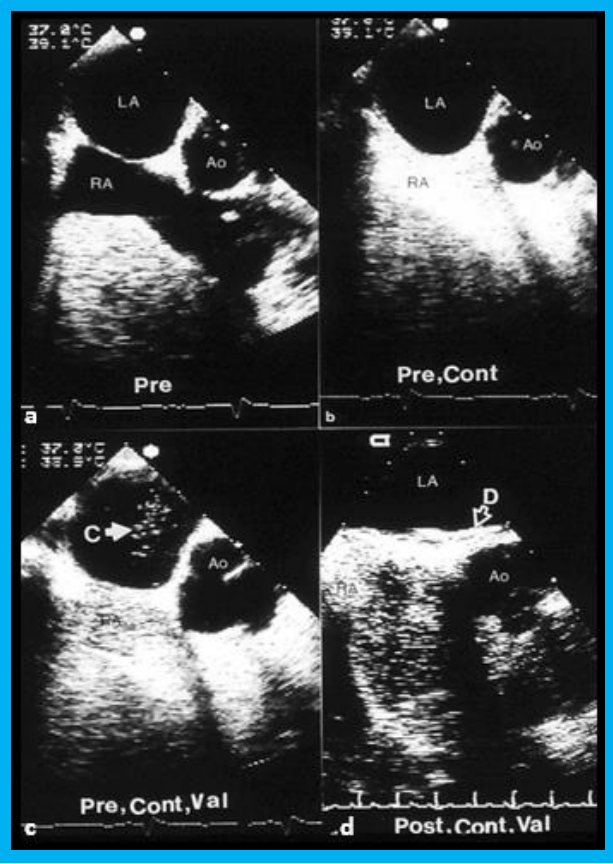
Figure 11. Selected video frames from transesophageal echocardiograms in an adult with presumed paradoxical embolism prior to (Pre) ( a – c ) and six months (post) ( d ) after closure of patent foramen ovale with buttoned device: Short axis views illustrate aorta (Ao) in the middle and right atrium (RA) and left atrium (LA) to the right before ( a ) and after ( b ) injection of agitated saline into the RA. Note that there are no contrast bubbles in ( b ). However, with contrast and Valsalva (Val) ( c ), the LA is opacified (C filled arrow). Study similar to c, performed six months following ( d ) (post, Cont, and Val) shows the device (unfilled arrow D) without contrast bubbles in LA. Note that contrast bubbles are seen in RA in ( b – d ). Reproduced from Rao P.S., et al. [9].